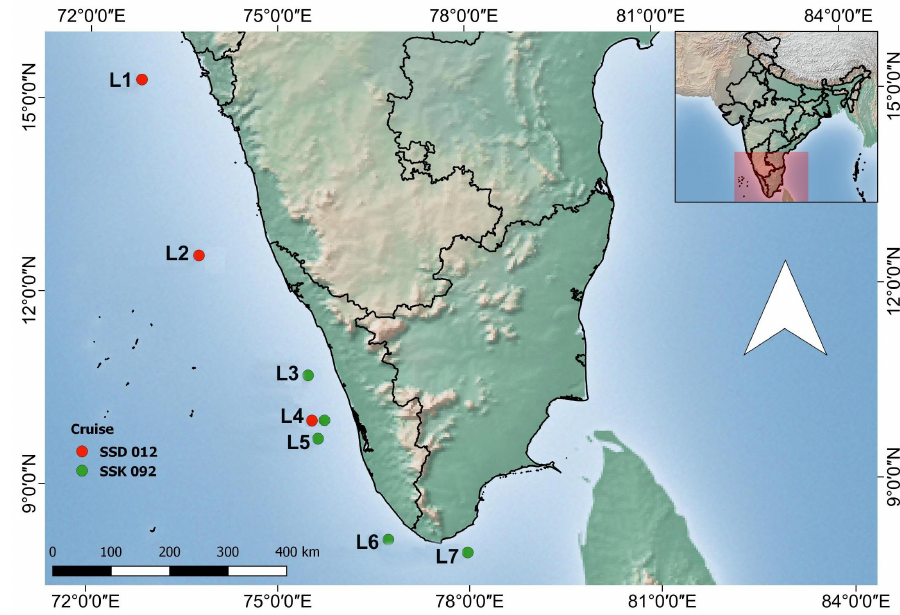
Figure 1. Sampling locations in the Arabian Sea. Three stations sampled during 2015 are indicated in red and six stations sampled during 2016 is indicated in